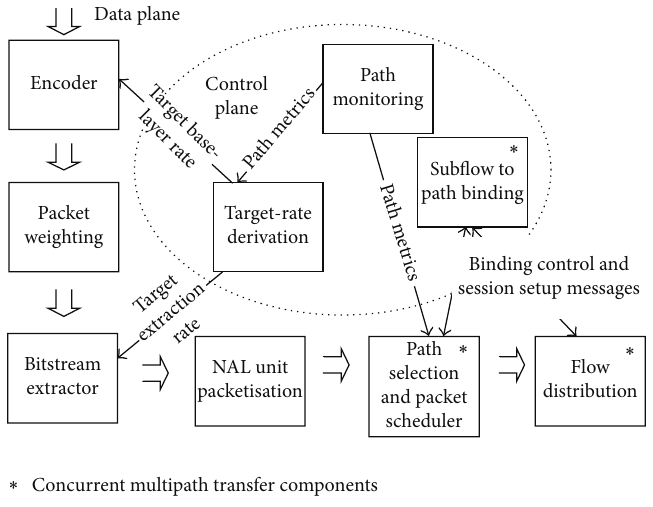
Figure 3: Overview of comprehensive streaming framework.